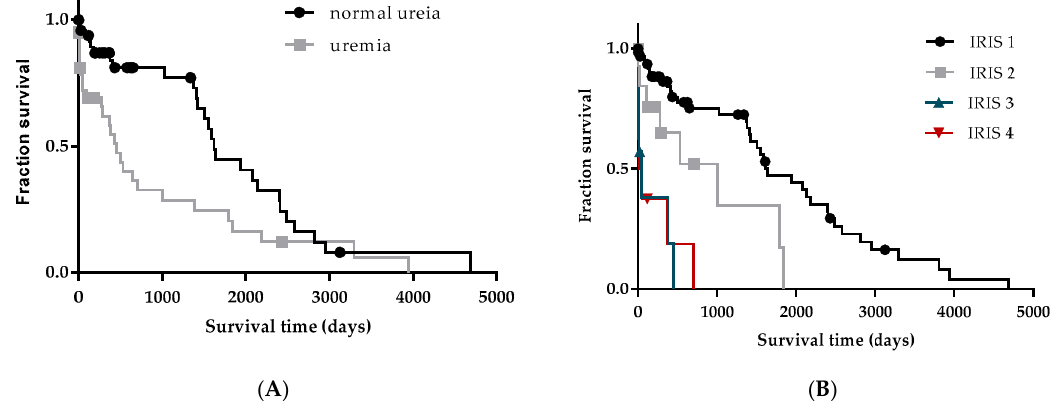
Figure 3. Influence of renal profile at the time of diagnosis on the survival time of patients with CanL. Blood creatinine levels were used to classify CanL patients according to the IRIS stage. Log-rank (Mantel-Cox) test was used to compare the survival time between animals with normal and abnormal blood urea levels ( A ) and between animals within different International Renal Interest Society (IRIS) stages ( B ). Both events (death) and censored data were considered. Dots, triangles and squares represent censored dogs.